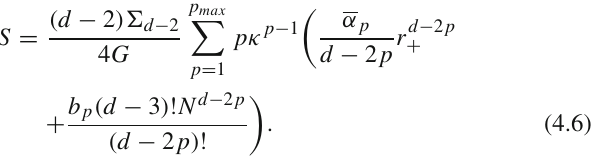
In this work we focused on the new solutions of Lovelock- scalar gravity in the background of quintessence and a con- figuration of strings. The Lovelock gravity is non-minimally coupled to a conformal scalar field, and the matter sources for gravity were taken in the form of quintessence and a cloud of strings. A specific choice of DCG for the Love- lock coefficients is used and the gravitational field equations are solved. The metric function (2.28) representing dimen- sionally continued hairy black hole with quintessence and a cloud of strings is calculated. Moreover, we also examined thermodynamics of the hairy black holes. The finite mass of black hole, Hawking temperature, specific heat capacity and Gibb’s free energy are calculated in terms of the event hori- zon radius. It is shown that the thermodynamic quantities are significantly affected by the contributions of quintessence and cloud of strings except for the Wald entropy which remains unchanged. We considered the entropy S , parameter of strings a , quintessence parameter q and conformal cou- pling coefficients b (cid:6) s as extensive thermodynamic variables and computed their conjugate quantities as well. We used these quantities for validation of the generalized first law and Smarr’s relation. We also performed thermodynamic stabil- ity analysis from both local and global points of views. The results for Hawking temperature and heat capacity in differ- ent spacetime dimensions have also been presented graphi- cally. The region of positive heat capacity and Hawking tem- perature shows that there is local thermodynamic stability of the black holes. It is shown that larger DCG hairy black holes are more stable than the smaller ones because as r + increases both the heat capacity and Hawking temperature also increase. The possibility of both the first and second order phase transitions is also visible from the plots of spe- cific heat capacity. Further, global thermodynamic stability of black holes can be analysed from the plot of Gibb’s free energy as a function of r +